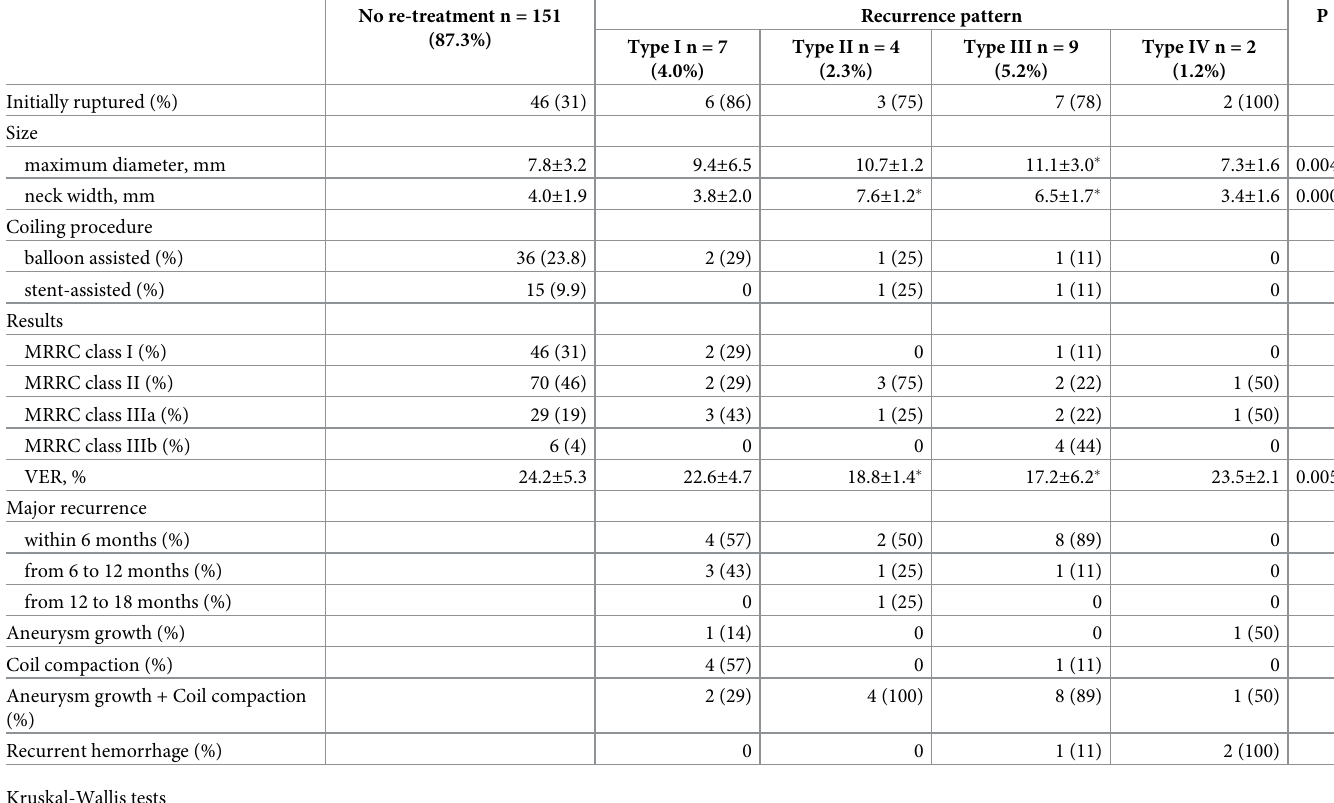
Table 3. Characteristics of recurrence